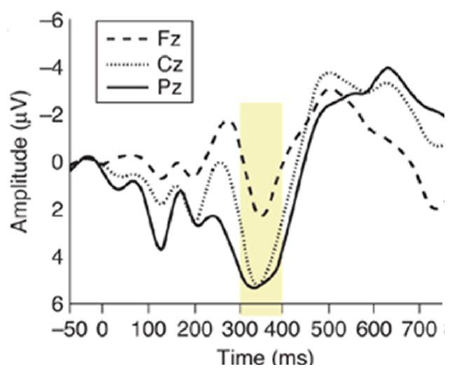
Figure 1. P300 component: the yellow box highlights the P300 component for averaged waveforms from different electrode positions. P300 amplitude decreases as the electrode site moves from anterior (Fz) to posterior (Pz).